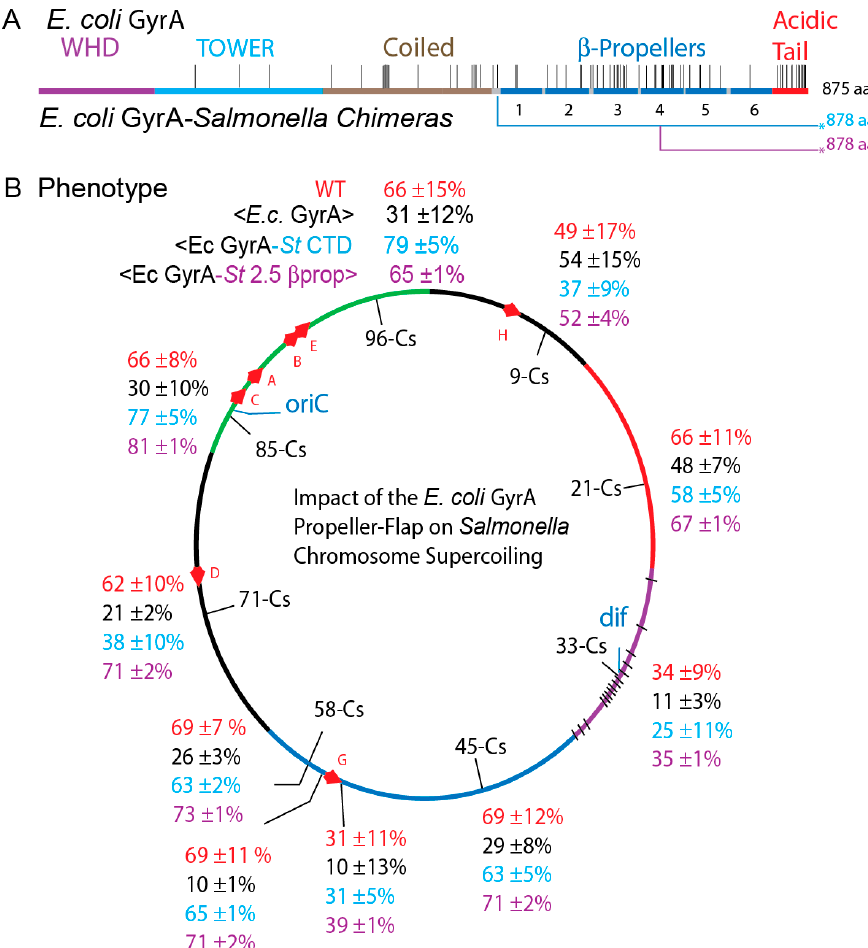
Figure 5. The C-terminal DNA binding domain of E. coli GyrA induces supercoiling losses in the Salmonella chromosome. (A) The genetic map of the different gyrase species tested is shown at the top (B) In vivo resolution results are compared for WT Salmonella gyrase—red numbers; strains with an E. coli gyrA replacing the Salmonella allele—black numbers; and two chimeras containing the N-terminal E. coli GyrA fused to Salmonella β -propeller elements at two points marked by blue and purple lines beneath the map.